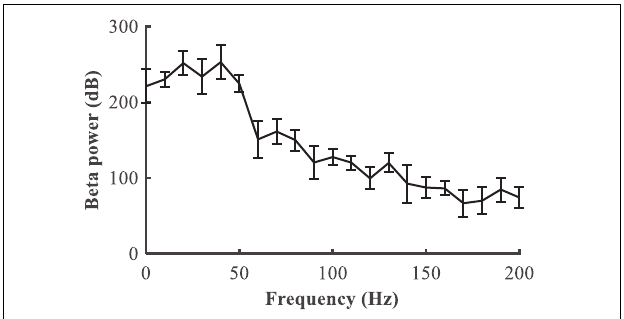
FIGURE 6 | Relationship between the deep brain stimulation pulse repetition frequency and the beta power in the LFP from the GPi (mean ± standard error for 50 trials).